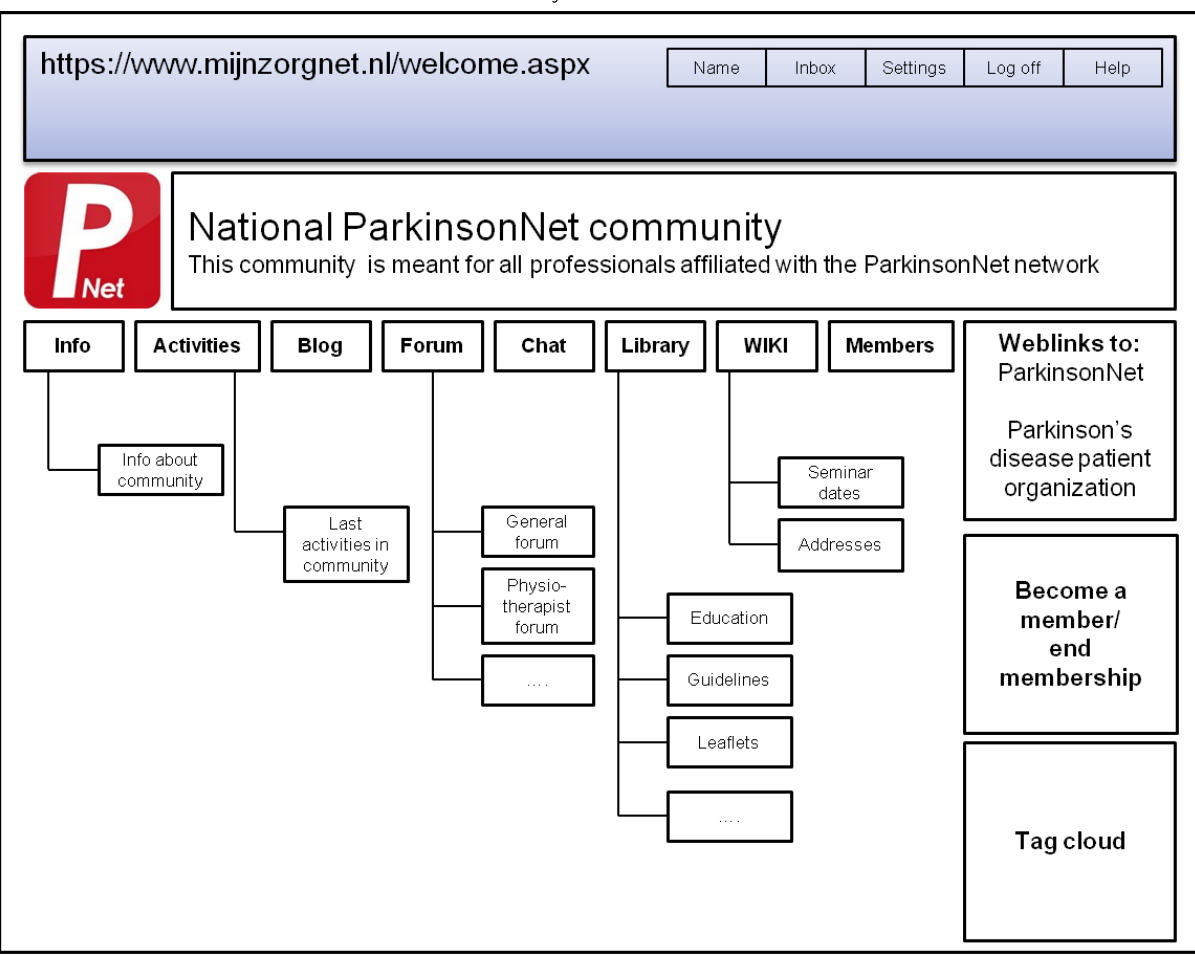
Figure 1. Schematic overview of the closed ParkinsonNet